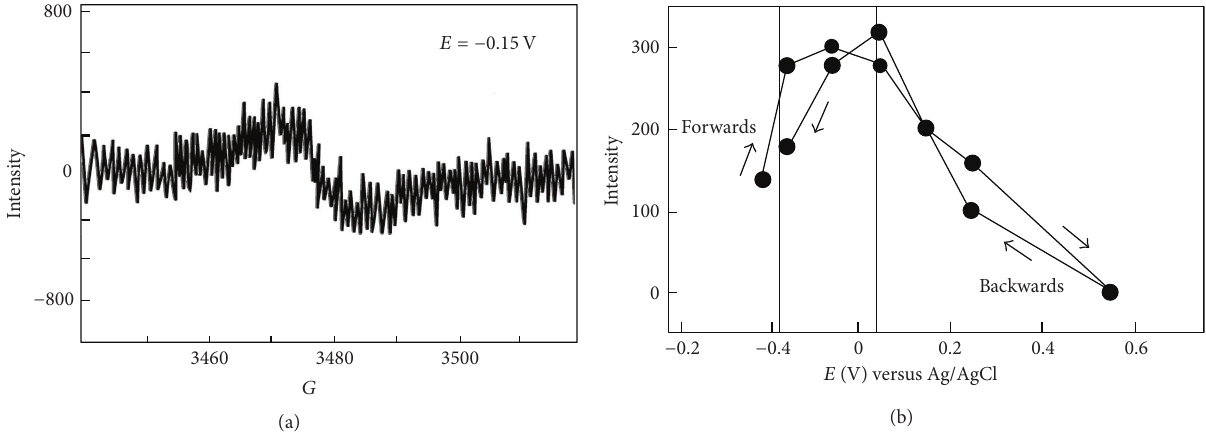
F 19: (a) �ypical �SR spectrum of an 80nm thic� POAP �lm on Pt electrode at pH 0.9. Plot (b) illustrates the change in the �SR intensities as a function of potential. e maximum intensities are shown between the dotted straight lines